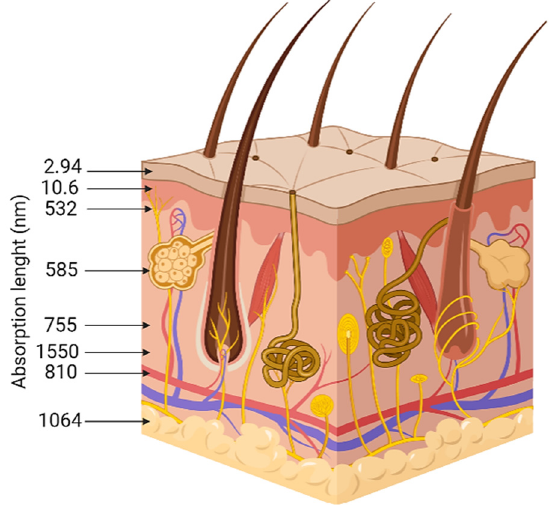
Figure 2. Relative penetration of the most common wavelenght in all layers of the skin. This image was designed based on the literature [29].